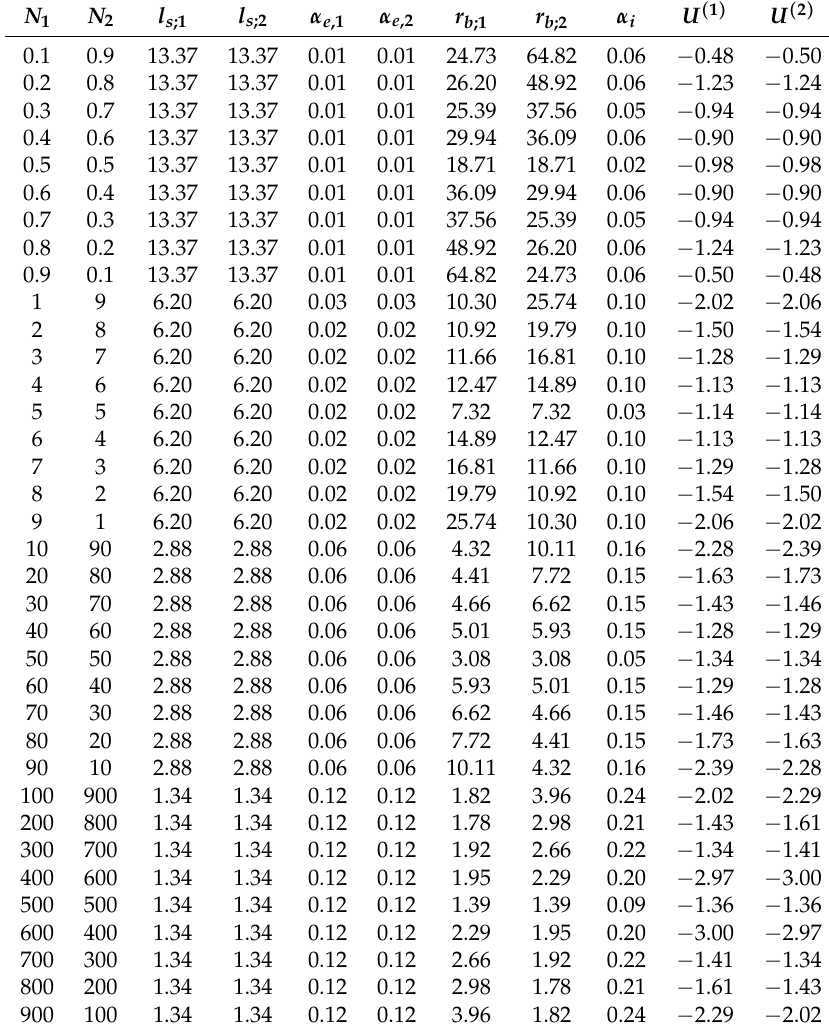
Table 2. The same as in Table 1 but for the case of Z 1 = Z 2 =